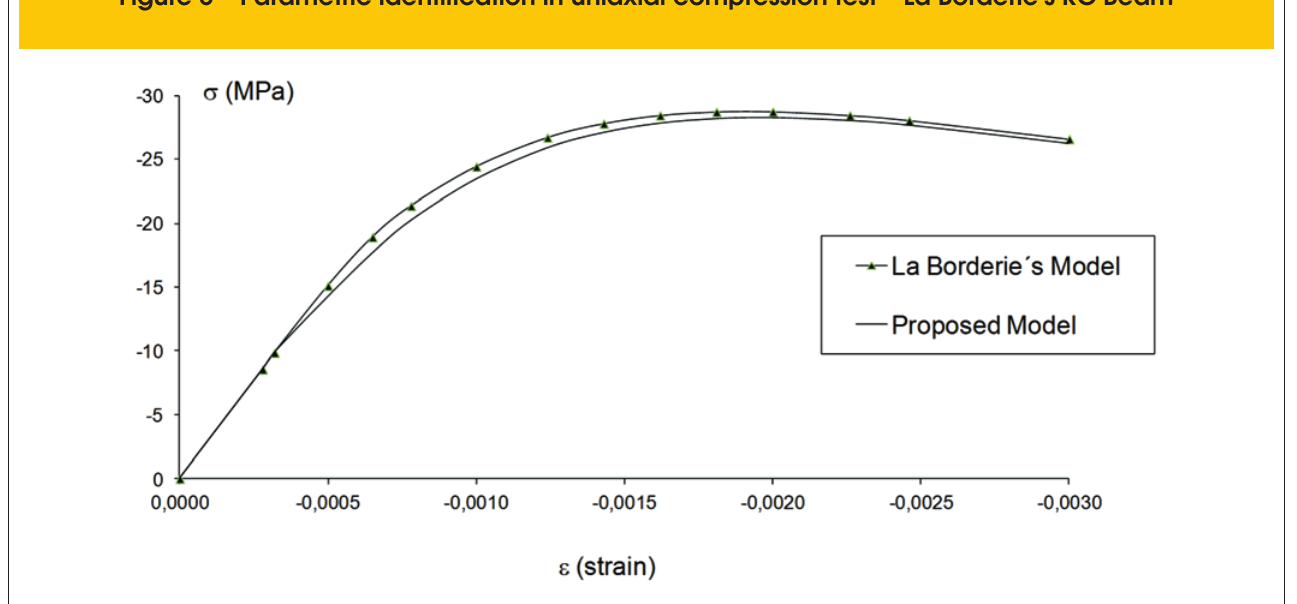
Figure 5 – Parametric identification in uniaxial compression test – La Borderie's RC